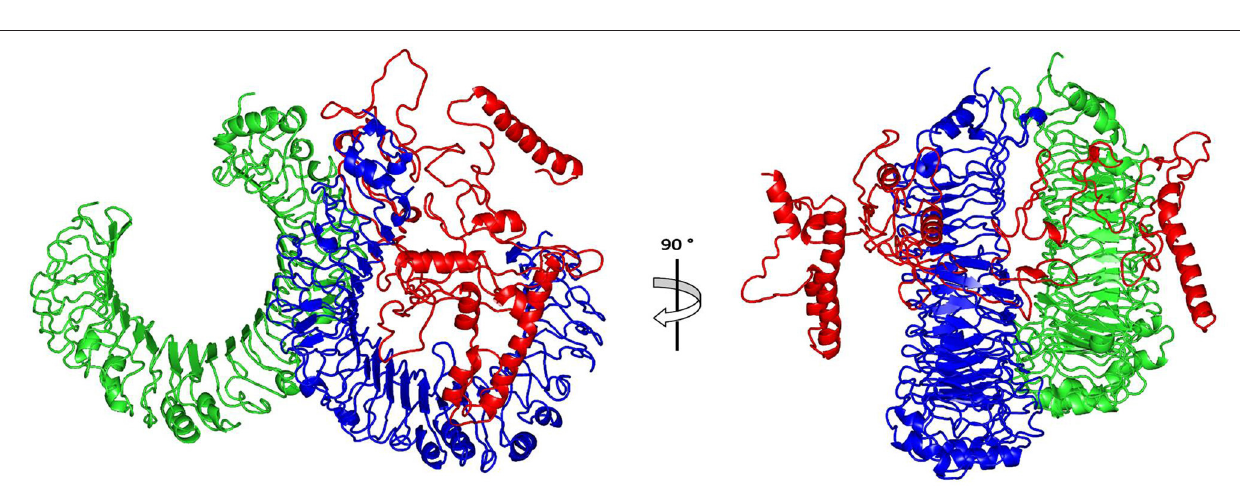
FIGURE 5 | Docked complex of vaccine constructs with human TLR4; vaccine constructs in red color and TLR4 receptor in green and blue